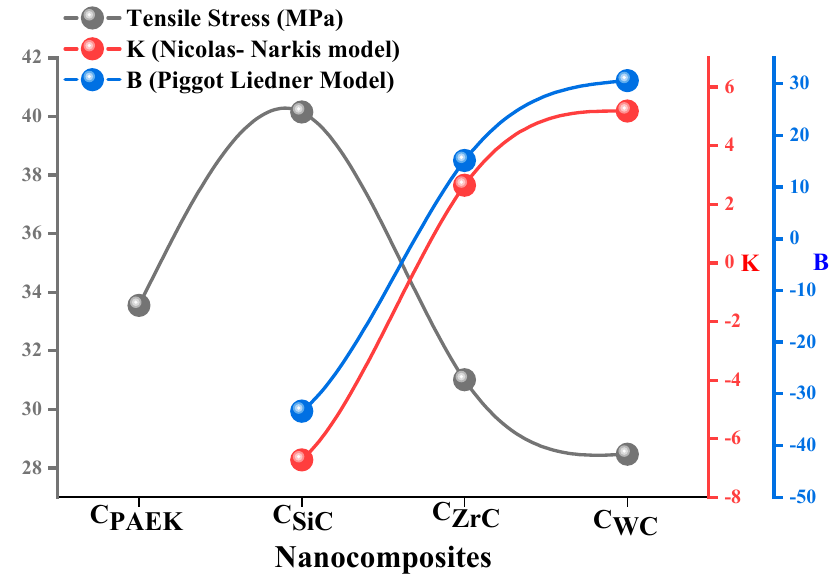
Figure 10. Correlation between interaction parameters and tensile stress.